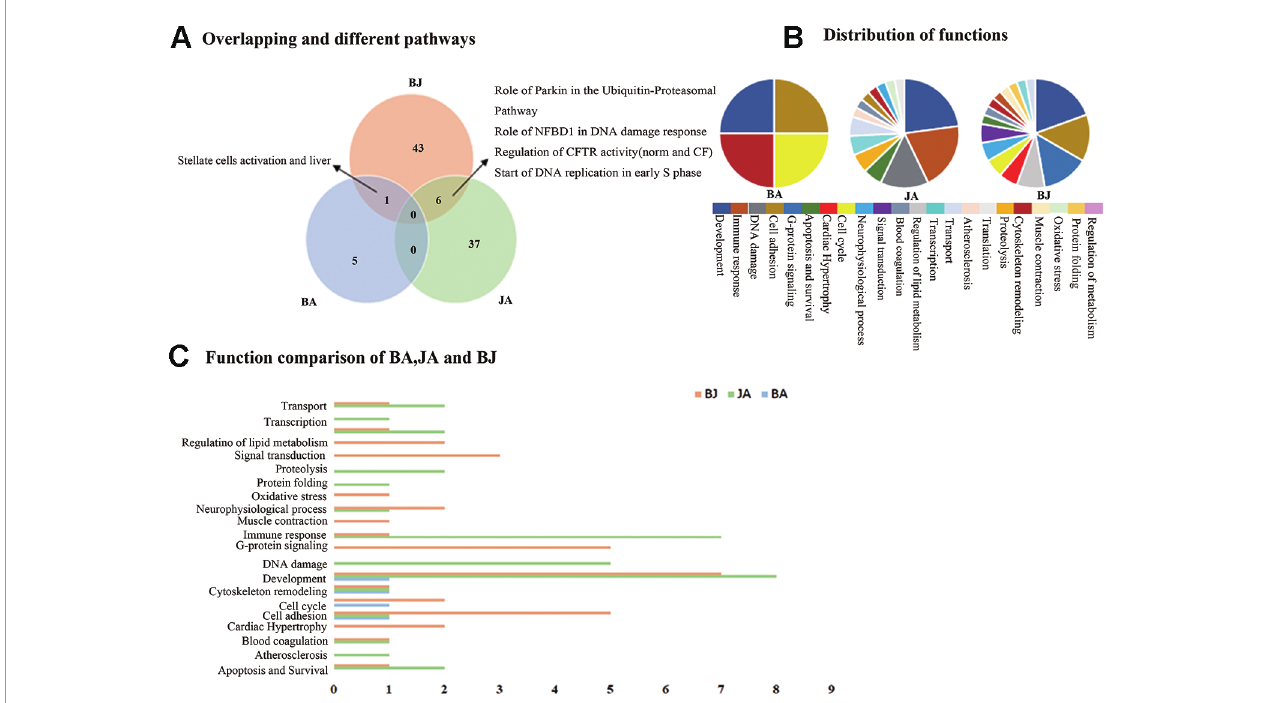
FIGURE 1 | The Wayne fi gures of overlapping and different biological functions and pathways among groups. BA (blue) denotes BA vs. CM groups, JA (green) denotes JA vs. CM groups, and BJ (orange) denotes BJ vs. CM groups (A) The Wayne fi gures of overlapping and different pathways among BA, JA, and BJ. (B) The function distribution among BA, JA, and BJ. (C) The functional comparison among BA, JA, and BJ. Only signi fi cant functions are shown in this fi gure based on a P value <0.05 and a fold change =>1.5 between